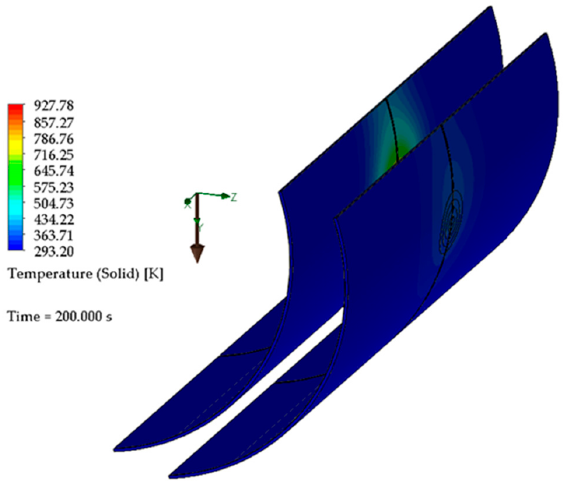
Figure 16. Temperature at 300 s.